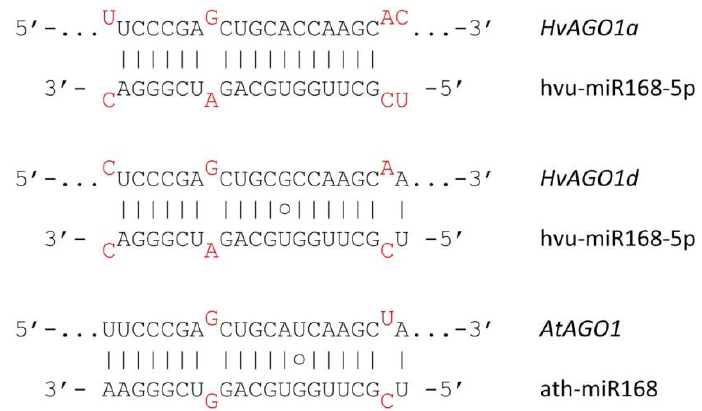
Figure 8. Secondary structure of miR168 / target site duplex region of identified barley and Arabidopsis thaliana AGO1 transcripts. G / U base-pairs are denoted by a circle, while mismatched bases are marked with red.